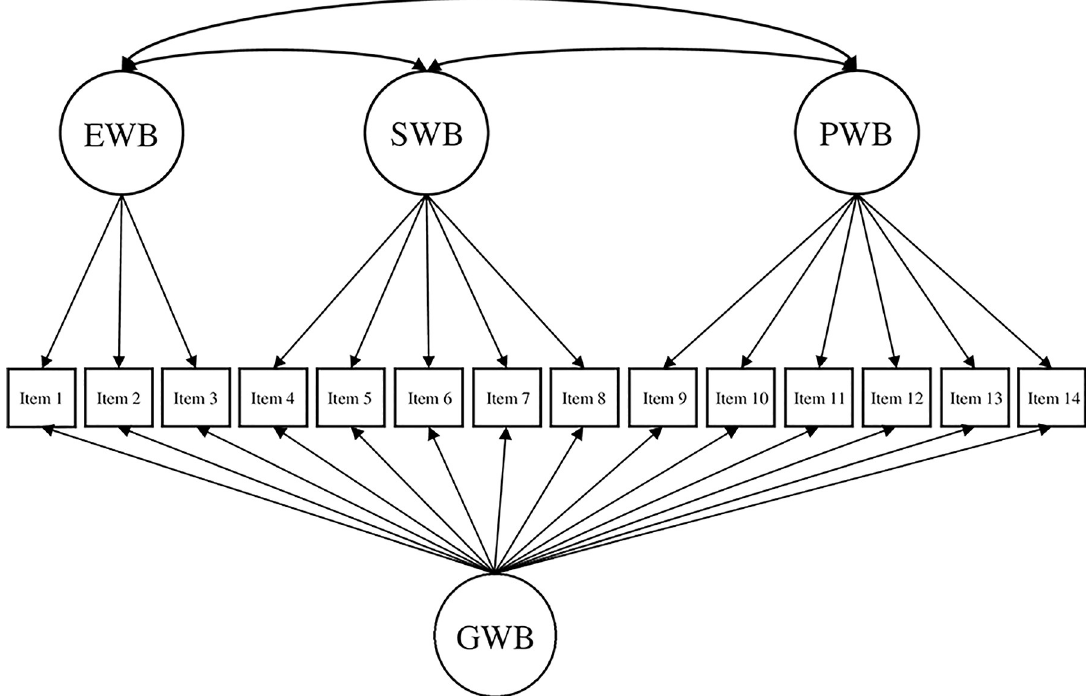
Fig 4. BiFactor model of the MHC-SF. Note . GWB = general well-being, EWB = emotional well-being, SWB = social well-being, PWB = psychological well-being.